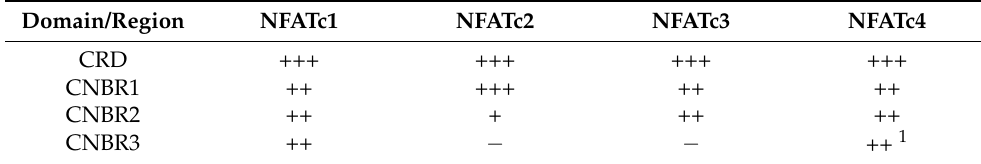
Table 2. Contribution of calcineurin (CN) binding regions (CNBRs) to CN/NFAT interaction.